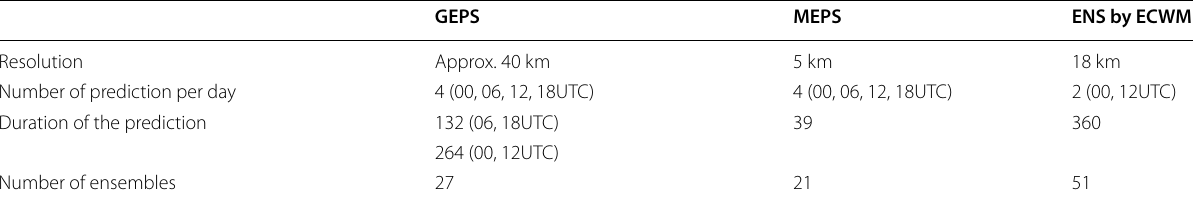
Table 1 Specification of GEPS, MEPS and global ensemble (ENS) by